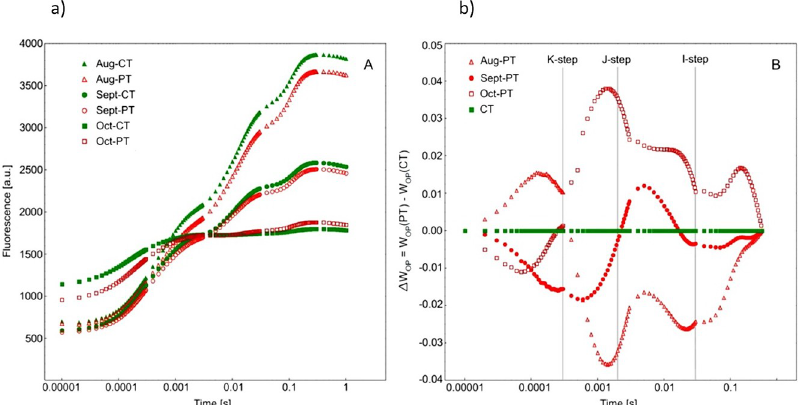
Fig 8. Chlorophyll fluorescence induction curves (a) and double-normalised plots of ChF induction curves (b) of leaf samples taken from pruned (PT) and control (CT) trees on August 1, September 30, and October 27,